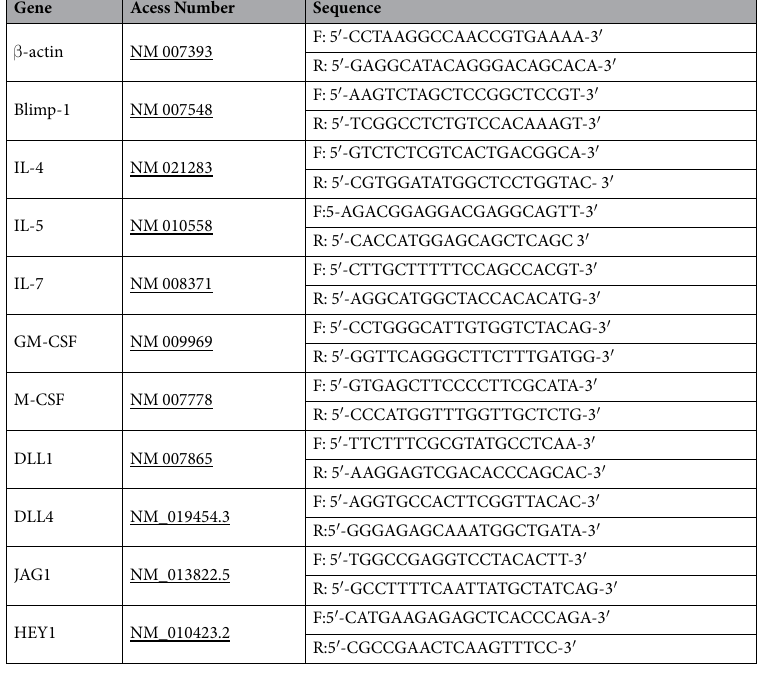
Table 3. Primers used for reverse transcriptase polymerase chain reaction